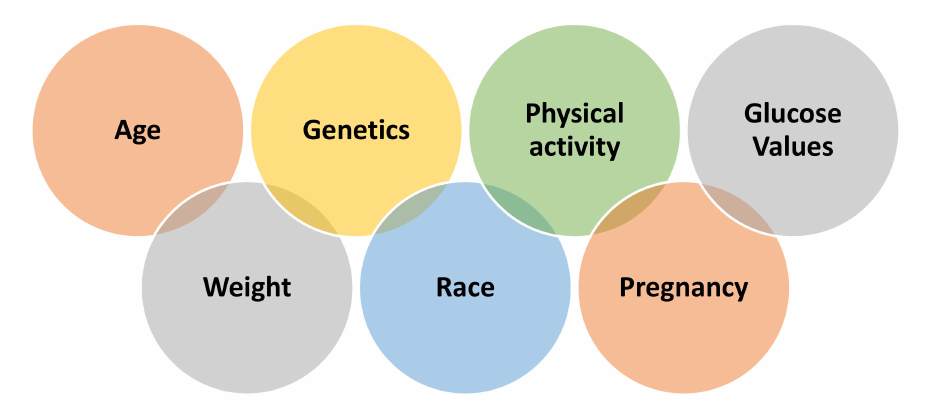
Figure 2. Major dimensions affecting